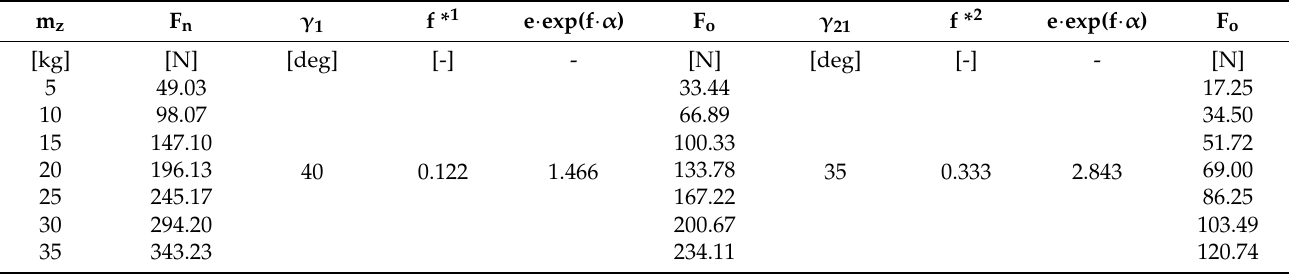
Table 2. Pulling forces in the sides of a cable belted around a